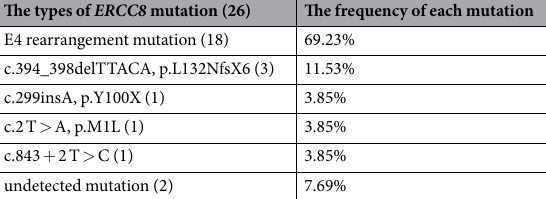
Table 2. The types and frequency of ERCC8 mutations.